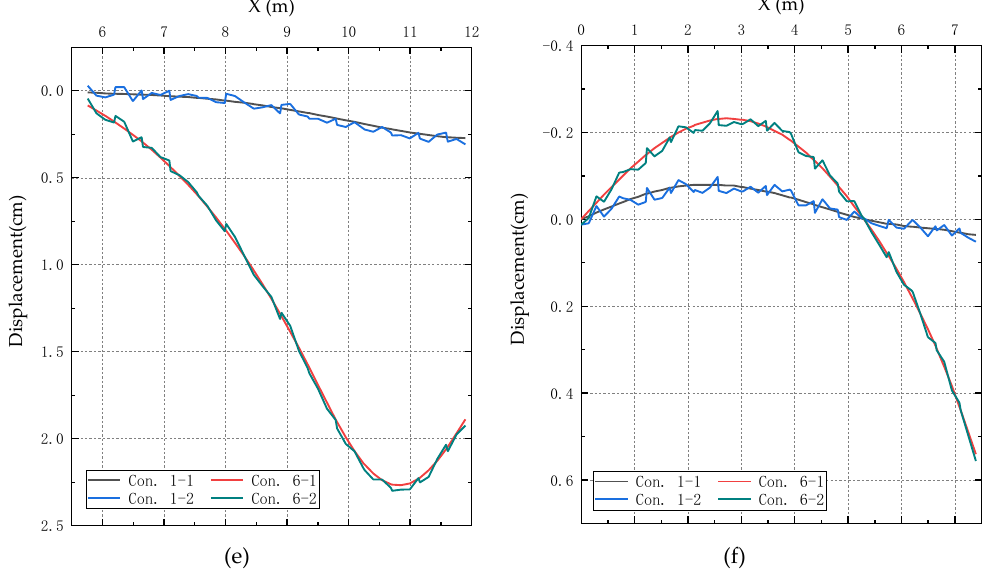
Figure 17. Comparison of two methods for obtaining deformation value for different fields of views: ( a ) Comparison for field of view 1; ( b ) comparison for field of view 2; ( c ) comparison for field of view 3; ( d ) comparison for field of view 4; ( e ) comparison for field of view 5; ( f ) comparison for field of view 6.